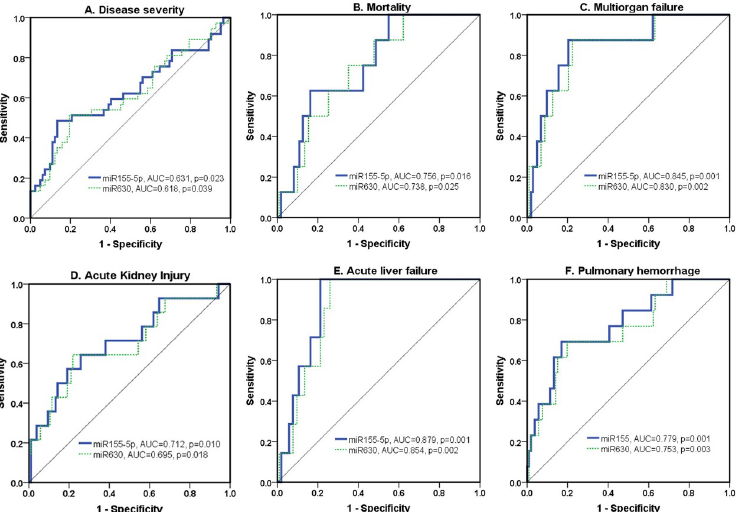
Fig 3. Receiver operating characteristic curve (ROC) for the association between serum miRNAs and (A) severity, (B) mortality, (C) multi-organ failure, (D) acute kidney injury, (E) acute liver failure, and (F) pulmonary hemorrhage. Next, a stepwise analysis combining the serum miRNAs levels with clinical predictors was performed to assess the discriminatory characteristics and build a most distinct severity predictor model. The addition of six serum miRNAs to the bicarbonate (HCO3-) level had the best discriminatory performance (combined AUCROC = 0.82, 95%CI; 0.73– 0.92, p = < 0.001) as shown in model 2 (Table